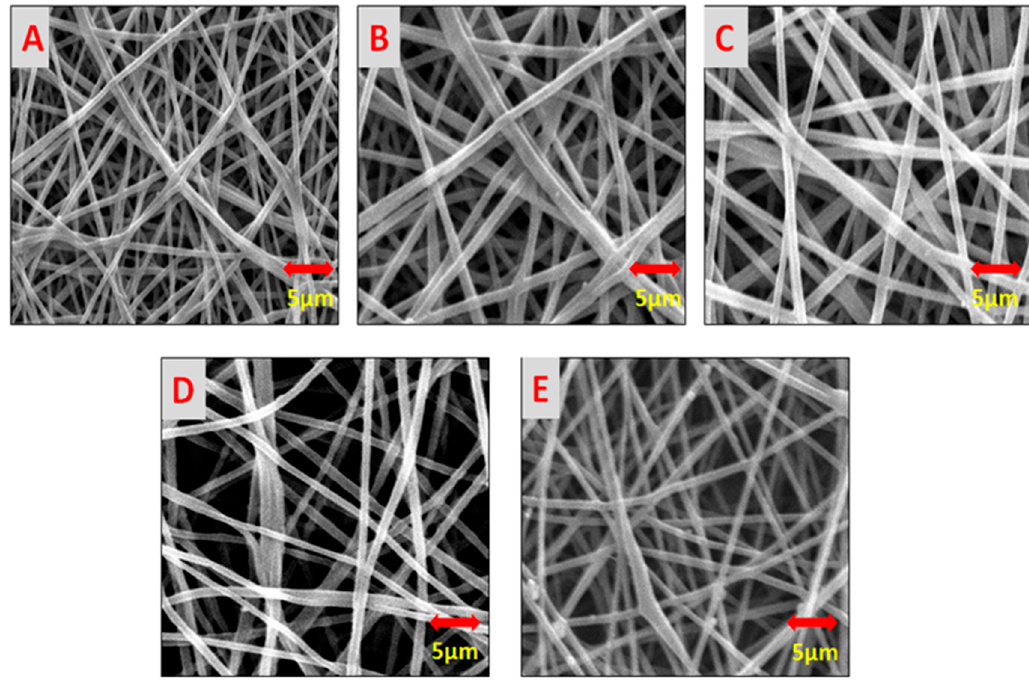
Figure 3. Surface morphology of the developed electrospun nanofibers. ( A ) Pure PVA nanofibers; ( B ) / PVA nanofibers; ( C ) 1.5% AV / PVA nanofibers; ( D ) 2.5% AV / PVA nanofibers; ( E ) 3% 0.5% AV/PVA nanofibers; ( C ) 1.5% AV/PVA nanofibers; ( D ) 2.5% AV/PVA nanofibers; ( E ) 3% ( B ) 0.5% AV